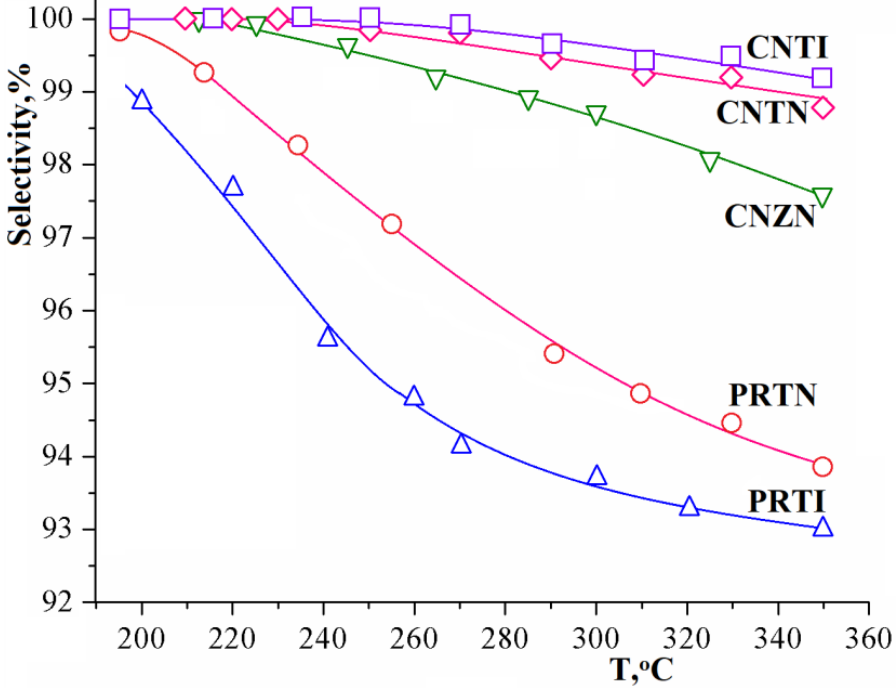
Figure 7. Temperature dependence of methanol conversion selectivity by reaction (1) in the methanol–water (1:1) system using various catalysts.